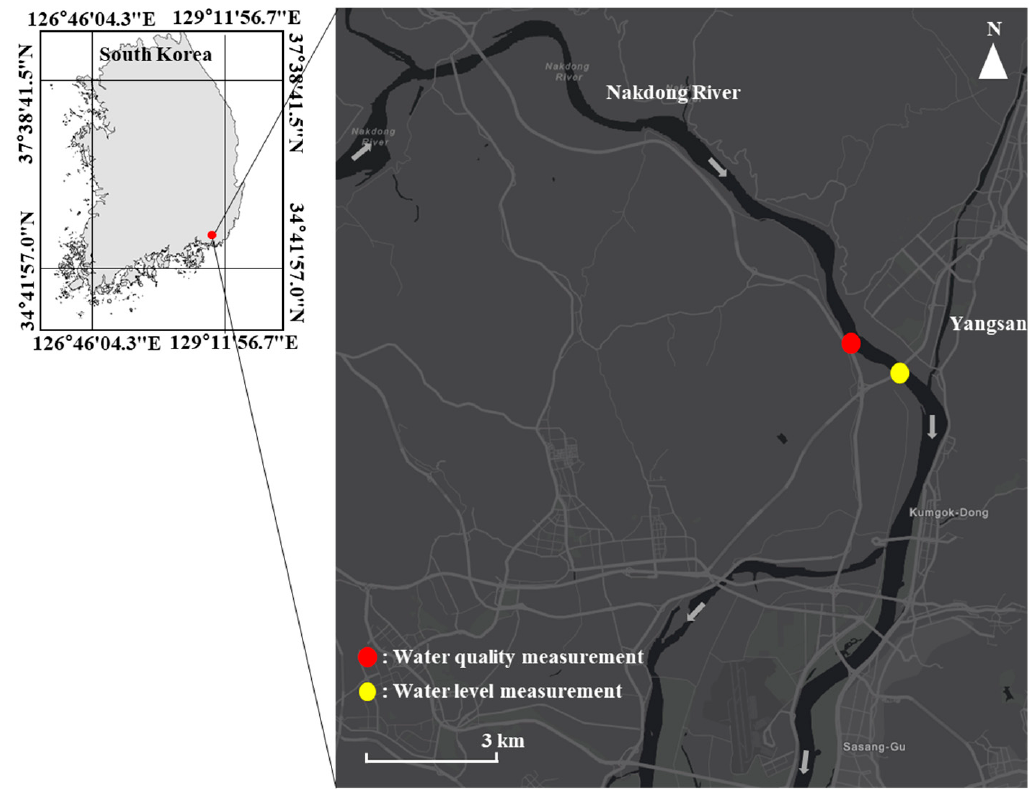
Figure 1. Study area and water sampling and water level monitoring sites in the Nakdong River Basin (NRB) in South Korea.